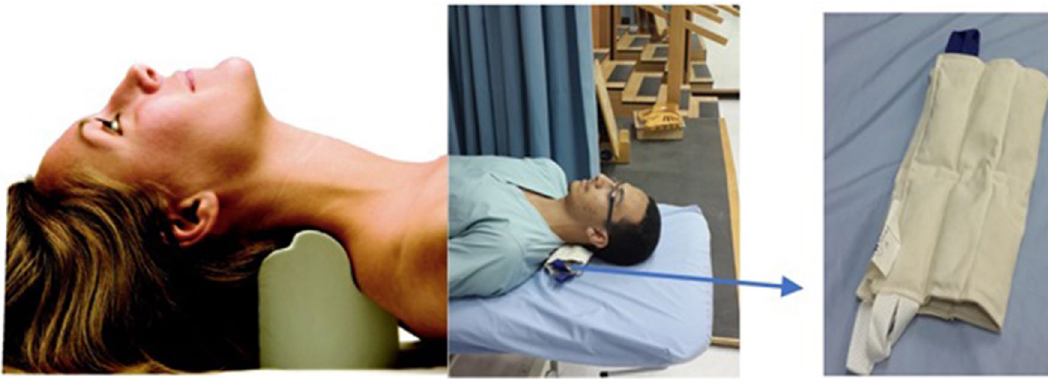
Figure 1. On the far left, the Denneroll orthotic is shown with a mid-cervical spine placement. In the middle, the placebo as a rolled cervical hydrocollator towel is shown placed in the mid-cervical spine. On the far right, a closeup of the placebo treatment is shown for the control group as a cervical hydro-collator towel. Copyright CBP Seminars, Inc. All rights reserved, reprinted with permission, and informed consent from all persons depicted was